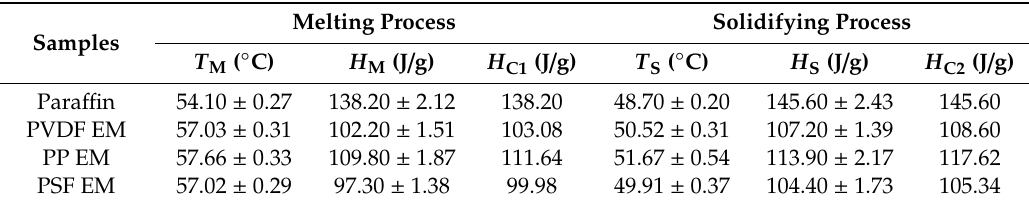
Table 2. Melting–solidifying properties for para ffi n and three encapsulation membranes; H M and H S are the measured latent heats while H C1 and H C2 are the theoretically calculated latent